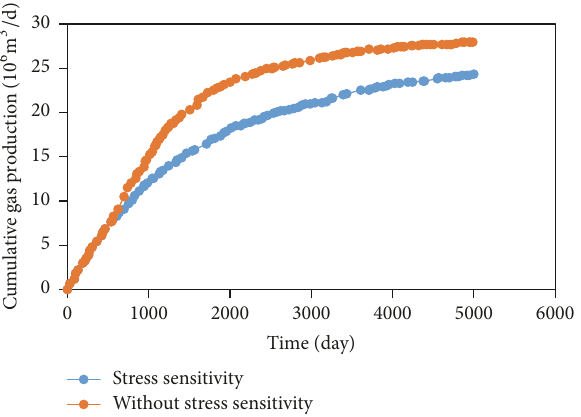
Figure 13: Effect of nonlinear factors on gas production.